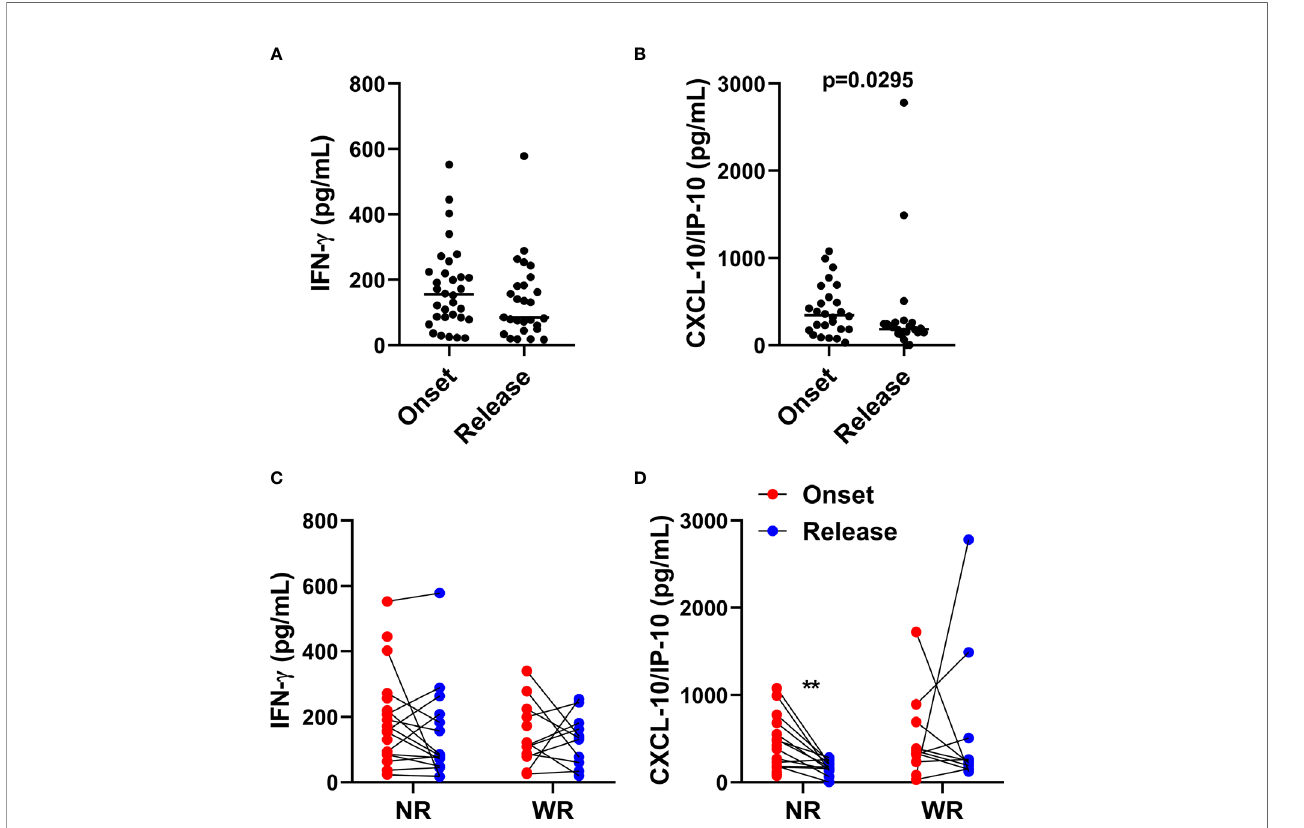
FIGURE 4 | CXCL10 (IP-10) production is associated with reduction of bacilloscopic index at 12-dose MDT release. Anticoagulant-free venous blood samples were collected at LL diagnosis (onset) and at completion of 12 doses of MDT (release), and the sera was aliquoted. Levels of IFN- g and CXCL10 (IP-10) in the sera were evaluated by ELISA. (A, B) Graphs show: IFN- g (A) and CXCL10 (IP-10) (B) levels in sera at disease onset and MDT release. (C, D) Graphs show: the levels of IFN- g (C) and CXCL10 (IP-10) (D) of each patient at disease onset and 12-dose MDT release classi fi ed in two groups, one with the patients who presented a reduction in the bacilloscopic index at release (WR, with reduction) and one for the patients who did not reduce the bacilloscopic index after 12-dose MDT (NR, no reduction). **p ≤